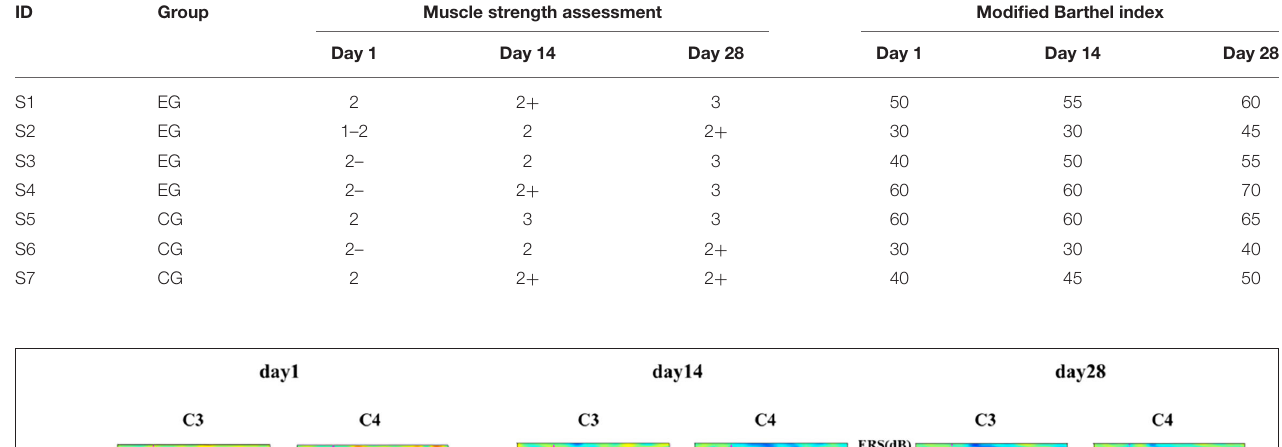
TABLE 2 | Changes of stroke patients with training duration were evaluated by the scale. ID Group